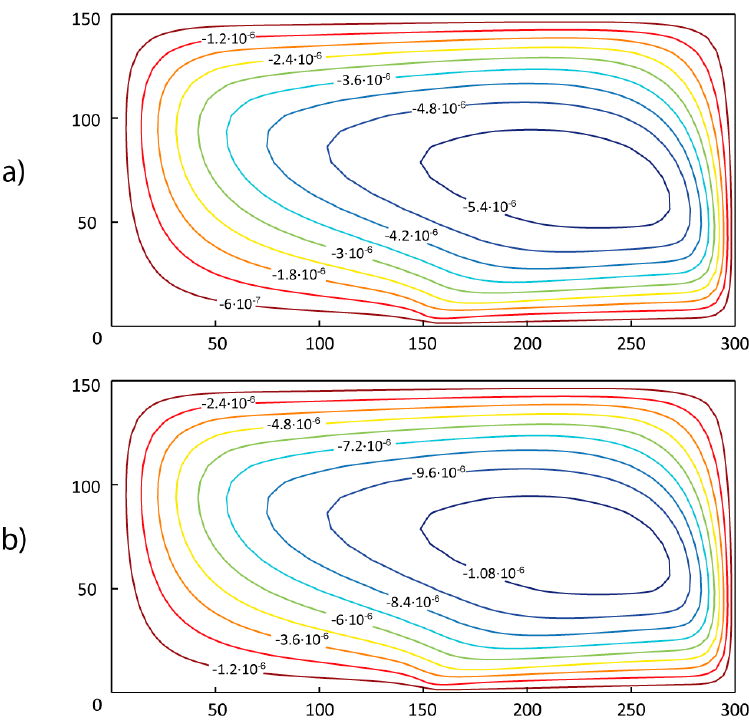
Figure 8. Steady state streamfunction patterns for the elder problem: ( a ) case 1; and ( b ) case 2. Comparison of Network and Elder simulations is carried out in Table 4. For two typical temperature isolines (T = 0.2 and 0.6), and regular x-locations, the y-locations are read from both solutions. The relative errors for all readings are always less than 10%. Table 4. Comparison of network method and elder solutions for the isolines of temperature 0.2 and 0.6. Elder Network Method Temperature